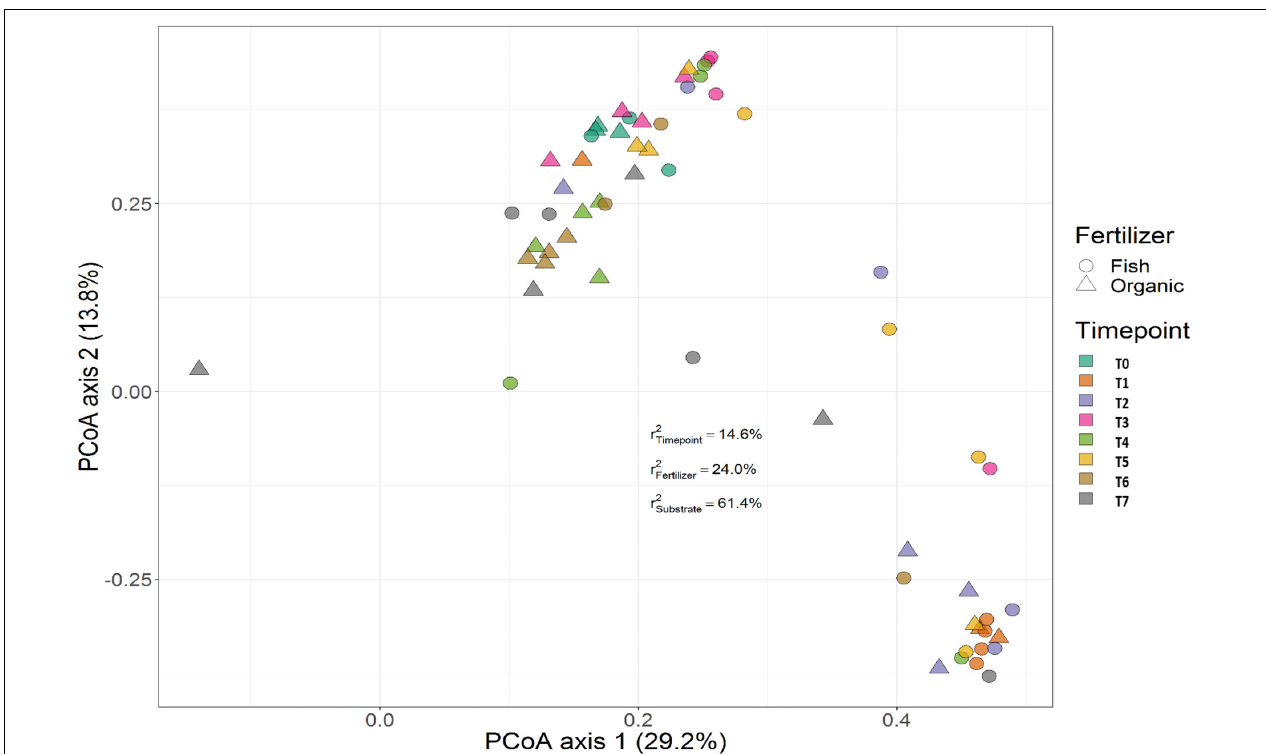
FIGURE 8 | Beta diversity of rhizosphere bacterial communities in growing media harboring tomato plants and supplemented with different fertilizers. Circles indicate communities supplemented with GBFISH. and triangles show bacterial communities amended with organic fertilizer (GBOF). Samples of growing media were followed over time to observe the bacterial community development. A color code on the right indicates the community sampled at different time points (time point 0-time point 8). “Substrate” indicates whether culture system contributed to the variance among bacterial communities. PERMANOVA results indicate that communities inhabiting growing medium were significantly different from those in soil, even if they hosted the same